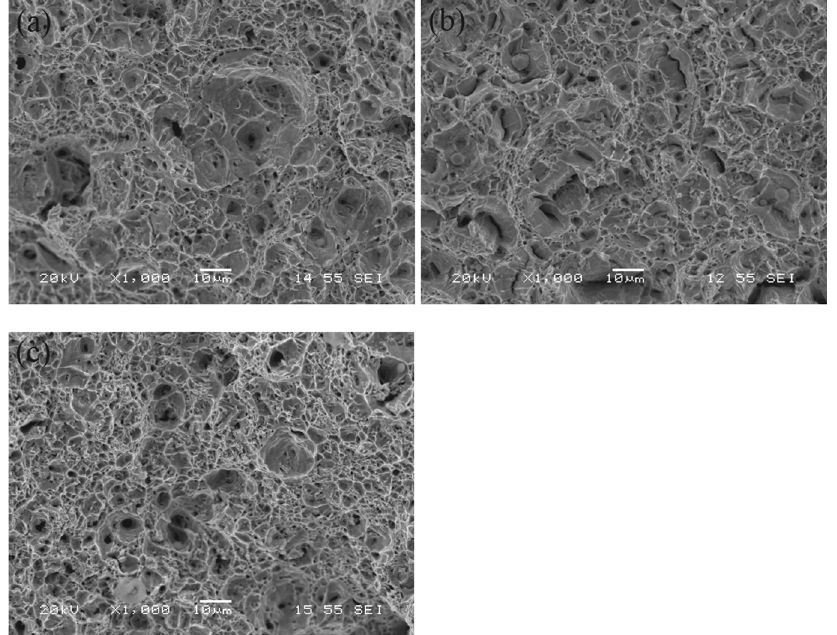
Figure 8: SEM micrographs of the tensile fracture surfaces ( × 1000): (a) VN1 (0.23 V – 0.019 N); (b) VN2 (0.22 V – 0.024 N); (c) VN3 (0.22 V – 0.034